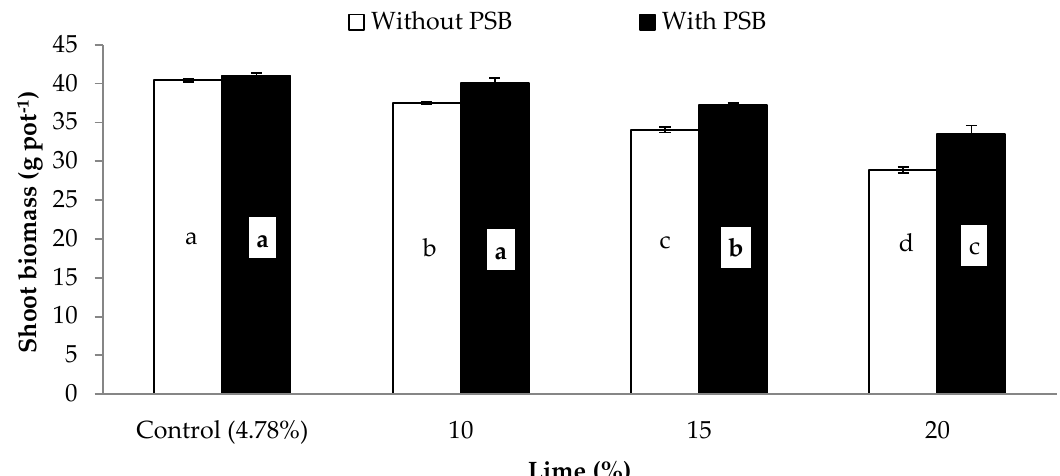
Figure 1. Effect of PSB on shoot biomass (g pot −1 ) of maize under varying levels of lime. Bars sharing letters are statistically comparable at p < 0.05 according to least significance difference (LSD) test. Error bars show standard error (n = 3).